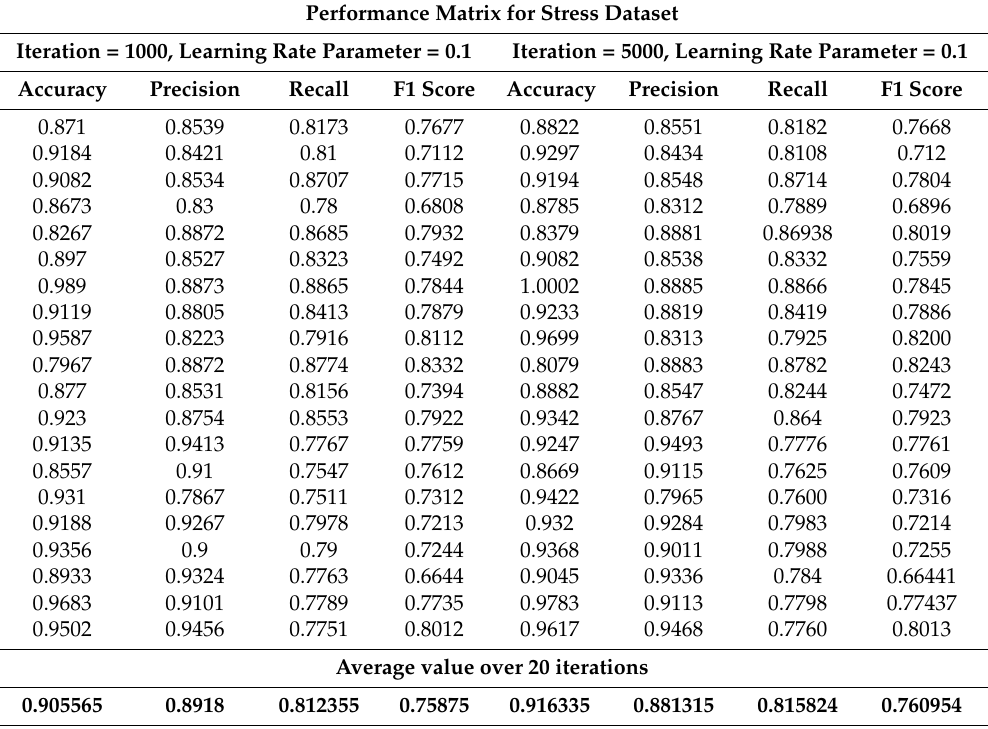
Table 6. Performance matrix for the stress classification model. Performance Matrix for Stress Dataset